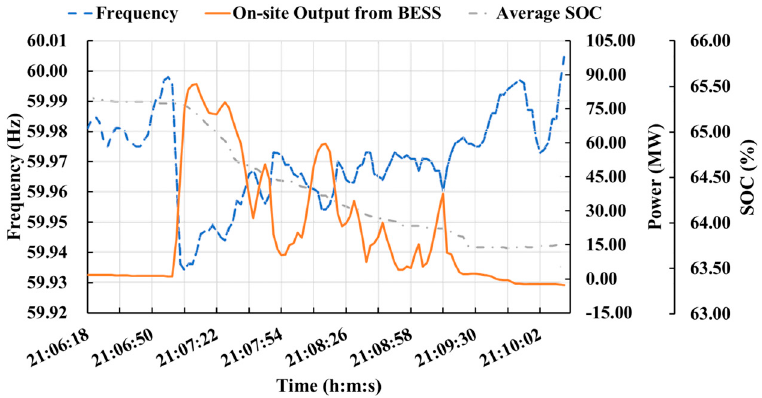
Figure 14. Operation result response to a large generator trip (Case 2).